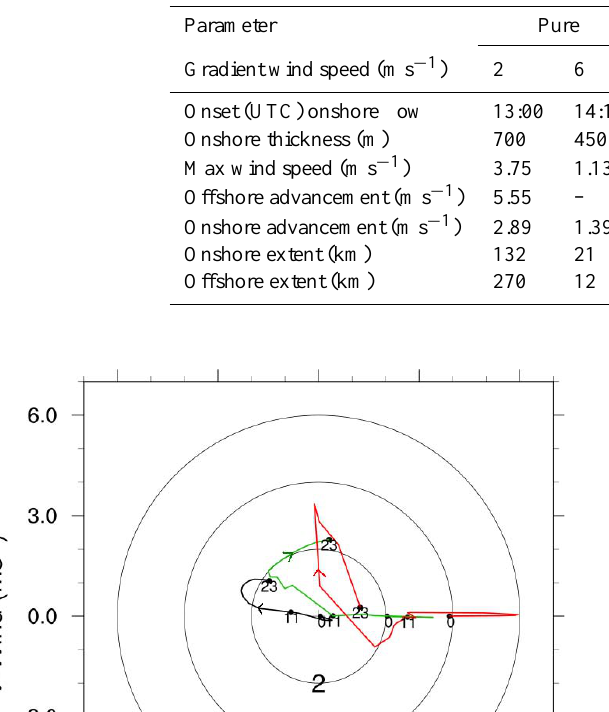
Table 3. Summary characteristics of different sea breeze type characteristics for single coast experiments using gradient wind speeds of 2ms − 1 and 6ms − 1 orientated offshore ( pure ), along shore with land to the left ( corkscrew ) and along shore with land to the right ( backdoor ). All simulations are based on the YSU PBL scheme and a SST of 287K.